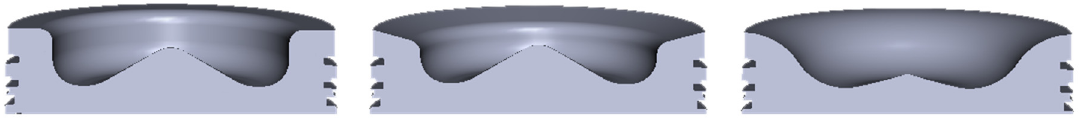
Figure 6. Cross-sectional views of the stock (left), tapered (middle), and bathtub (right) piston bowl geometries.